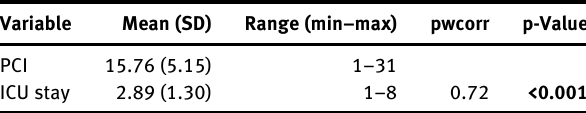
Table  : Correlation between PCI and length of ICU stay. Variable